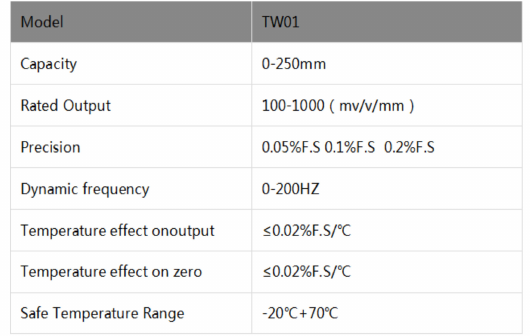
Figure 4. Partial parameters of LVDT.